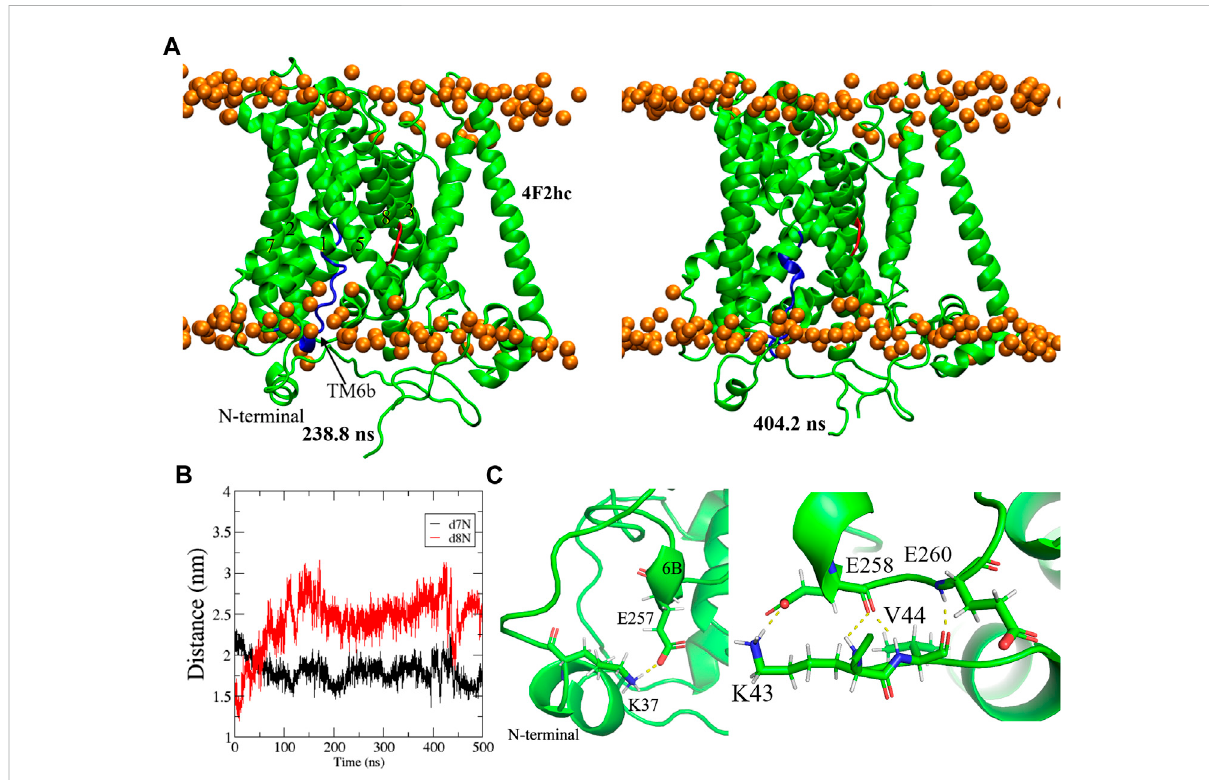
FIGURE 6 (A) Representative snapshots of equilibrium inward-open Sx c − structure in membrane at different times of simulation. TM6b and a turn of TM8arelabeledbytheblueandred,respectively.The intracellularsurfaceisatthebottom. (B) DistancefromtheN-terminalhelixto theintracellular loops between TM8 and TM7 during the MD simulation. (C) A close-up view of the interaction of TM6B and N-terminal